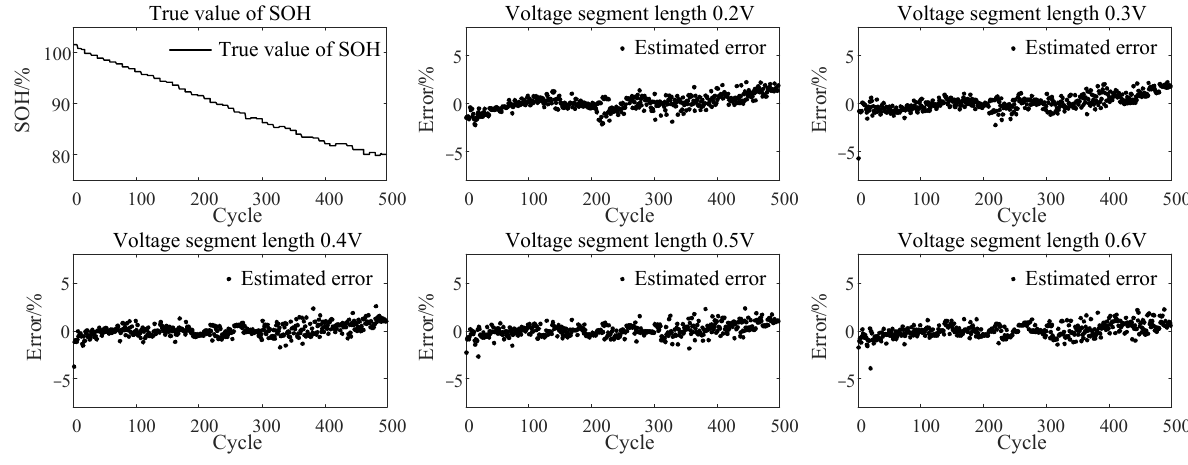
Figure 7. SOH estimation results under 0.5 C discharge.